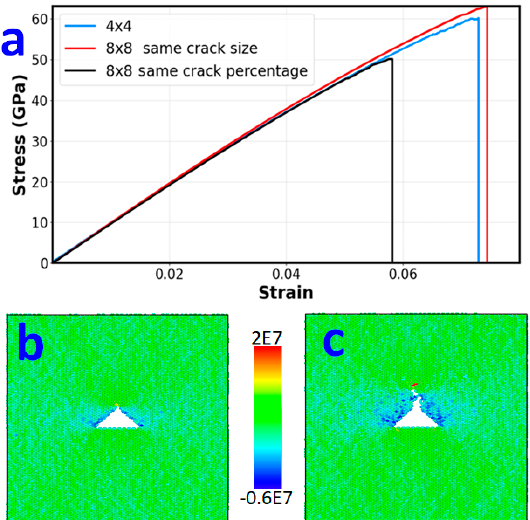
Figure 4. ( a ) Stress–strain relationships of SLGSs with different sized cracks. Three systems all with the same vertex angle of 90° are compared. The tensile simulations were carried out under the fol- lowing conditions: The temperature was 300 K. The pressure was 0.0001 GPa (1 atm). The strain rate was 10 9 s − 1 . The model I loading was applied along the x axis (armchair direction). Snapshots of the x-component atomic stress distributions in the system with the size of 4 × 4 (or 20.7 nm × 20.5 nm with 16,128 lattice sites) can be seen in ( b ) for the system just before crack and ( c ) after the crack propagation. The colormap is in the middle.